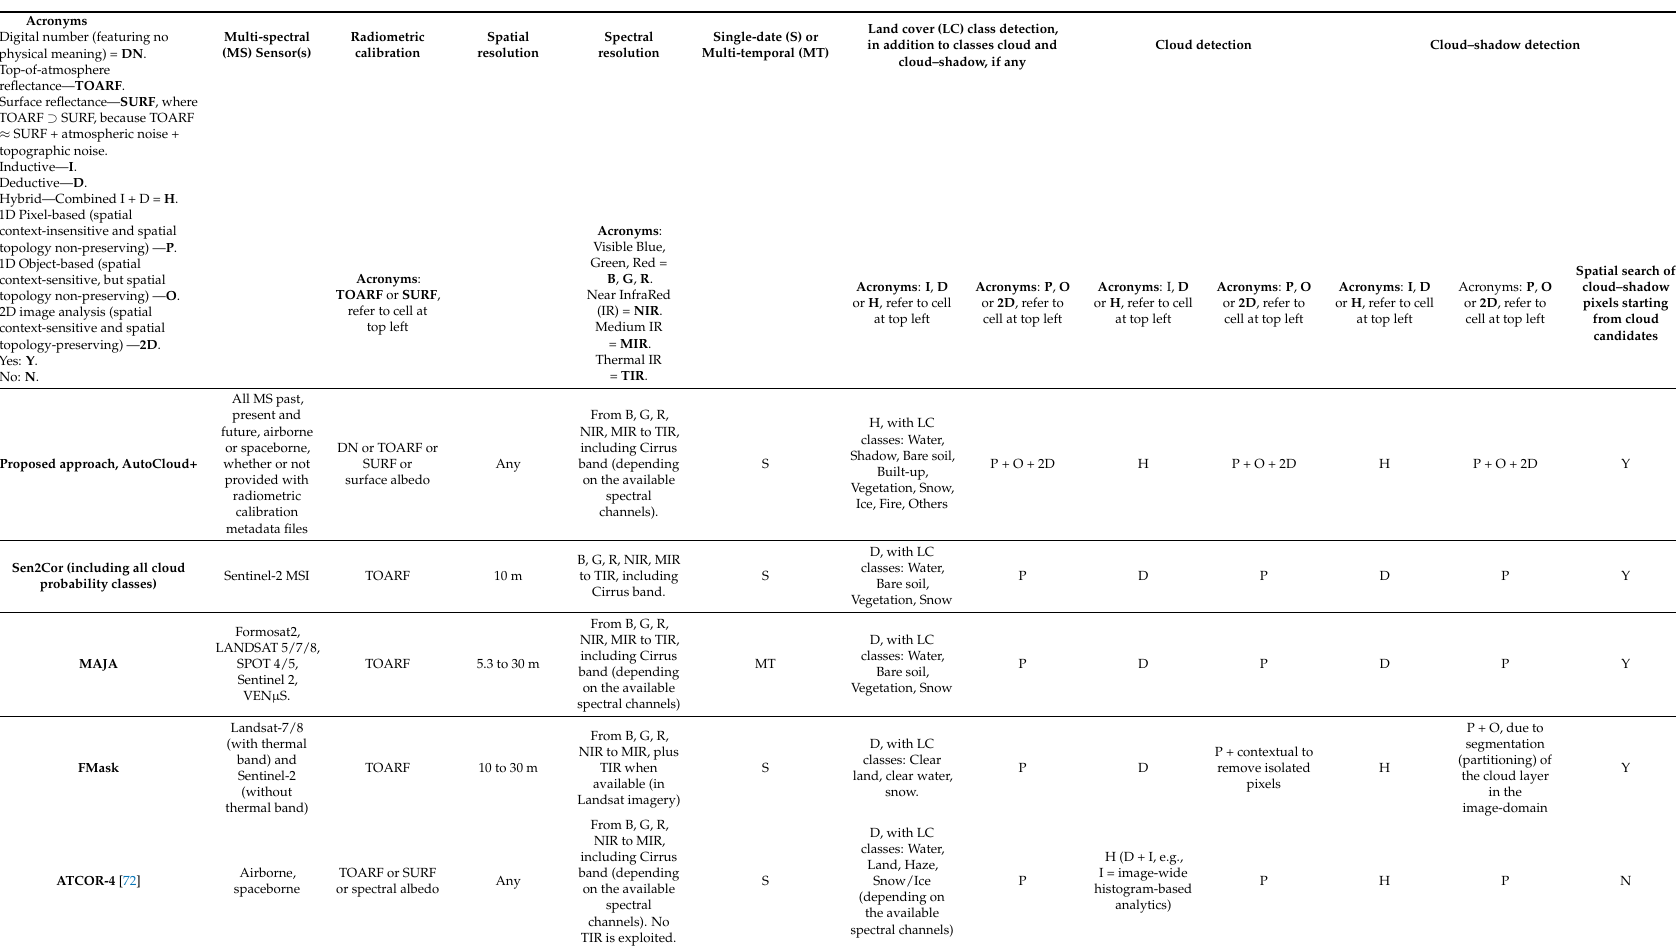
Table 5. Comparison of alternative joint cloud and cloud–shadow detection algorithms at three levels of understanding of an information processing system proposed by Marr, specifically, information/knowledge representation, system design (architecture) and algorithm (refer to Section 1) [13,19,76,82,83]. Acronyms Digitalnumber(featuringno physicalmeaning)= DN